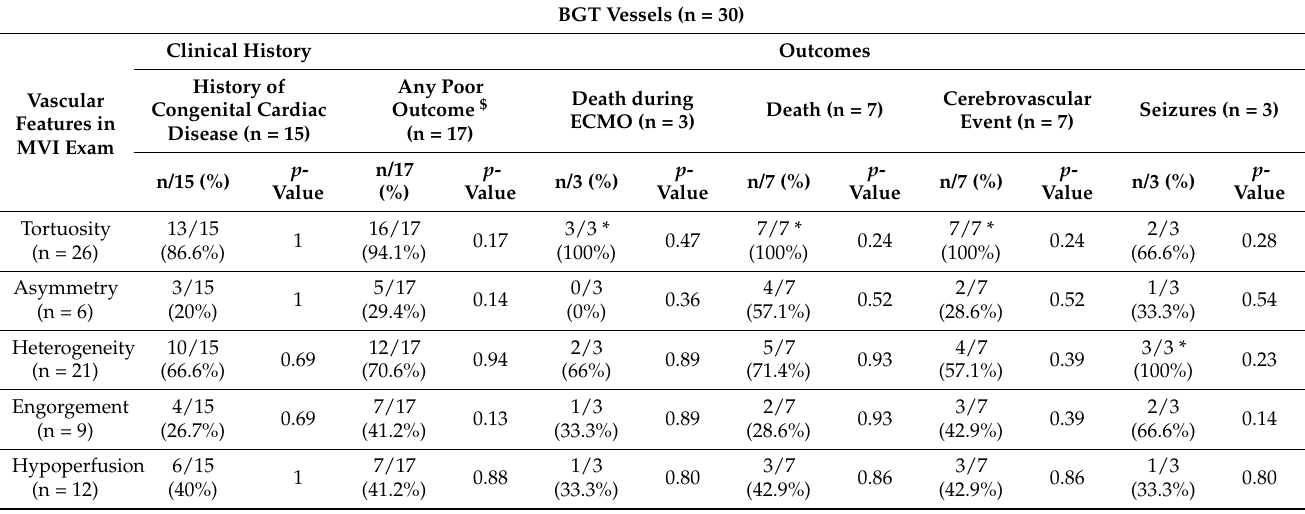
oxygenation. $ Included death, cerebrovascular events, and/or seizure within a year of ECMO cannulation. * Represents all patients with the condition in that column.